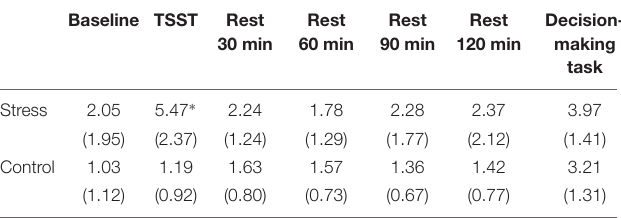
TABLE 1 | Means (Standard Error of Mean) in the intensity of stress and results of ANCOVA.